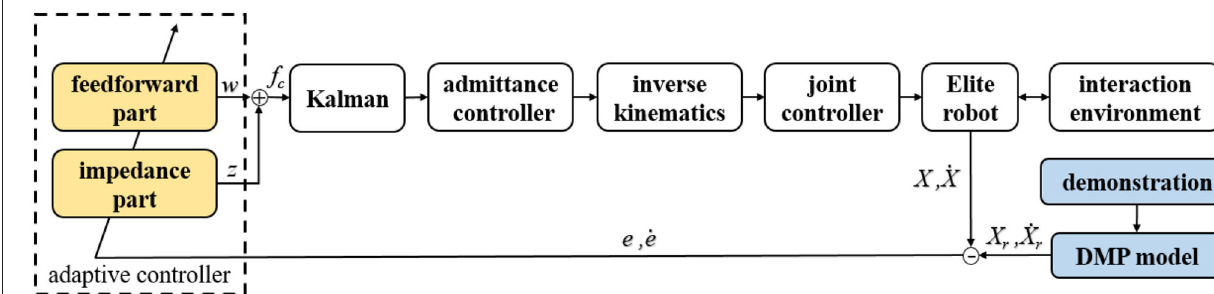
FIGURE 1 | Overview of the proposed framework.